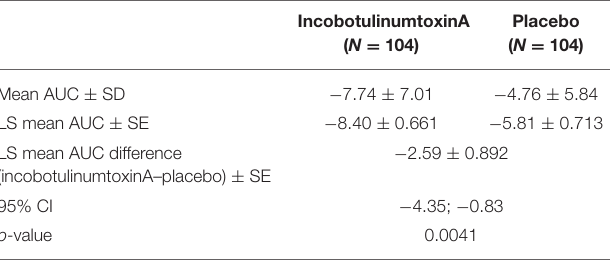
TABLE 2 | Summary statistics and ANCOVA of AUC for the change from baseline in MAS-PF to the end of MP (BOCF, FAS).